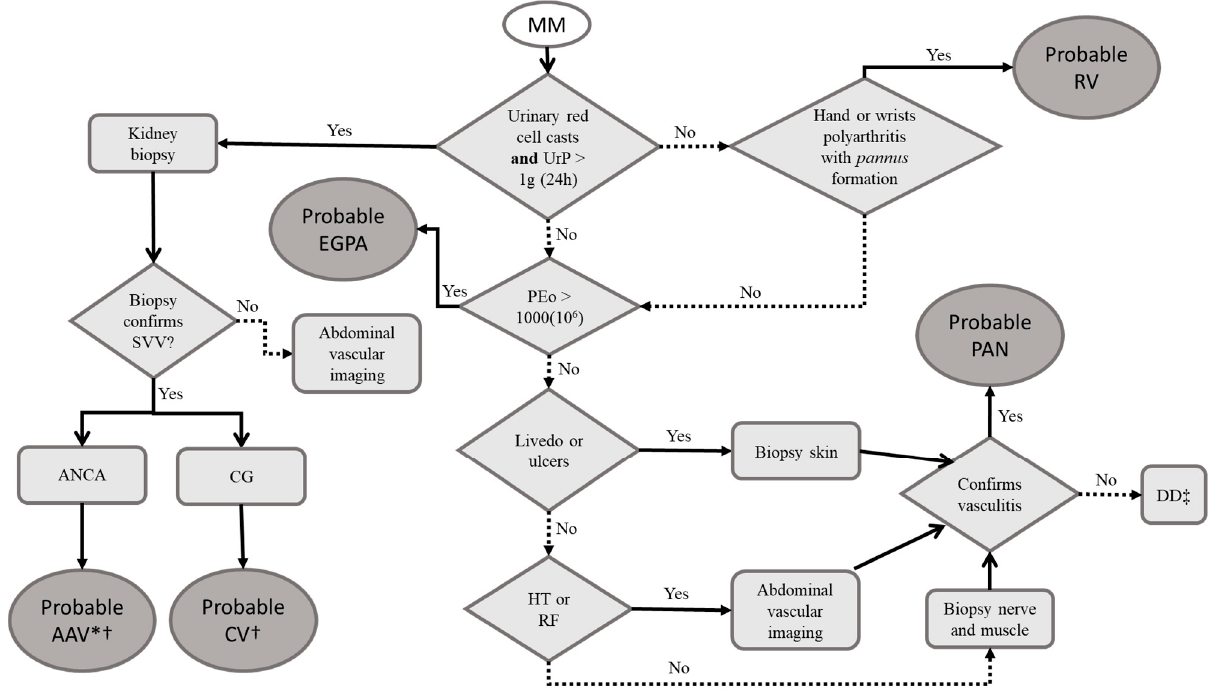
Figure 4. Proposed diagnostic flow for confirmed multiple mononeuropathy. Legend: AAV: anti- neutrophil cytoplasmic antibody-associated vasculitis; ANCA: antineutrophil cytoplasmic anti- body; CG: serum cryoglobulin; CV: cryoglobulinemic vasculitis; DD: differential diagnosis; EGPA: eosinophilic granulomatosis with polyangiitis; HT: hypertension; MM: multiple mononeuropathy; PAN: polyarteritis nodosa; PEo: peripheral eosinophils; RF: renal failure; RV: rheumatoid vasculitis; SVV: small vessel vasculitis; UrP: urinary protein. * If immunofluorescence for antineutrophil cyto- plasmic antibodies is perinuclear, confirm with anti-myeloperoxidase; if it is cytoplasmic, confirm with anti-proteinase 3. † If antineutrophil cytoplasmic antibodies are negative, dose cryoglobulins. If cryoglobulins are absent, order antineutrophil cytoplasmic antibodies. If both are negative, treat as antineutrophil cytoplasmic antibody-associated vasculitis (see text) because of the severity. ‡ Consider guiding biopsy by nerve conduction studies and electromyography, or alternatives to mul- tiple mononeuritis, such as hereditary neuropathy with liability to pressure palsies.